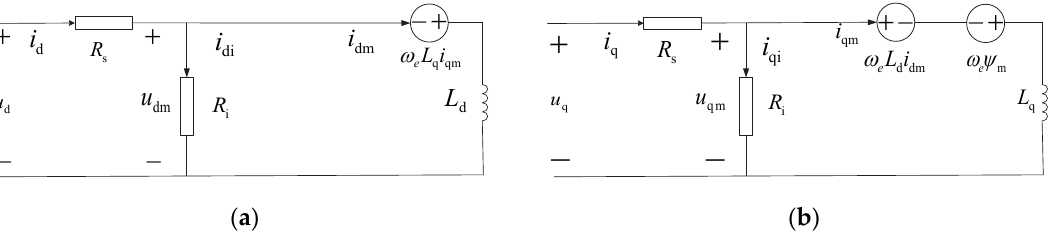
Figure 1. ( a ) D ‐ axis equivalent circuit; ( b ) Q ‐ axis equivalent circuit. Figure 1. ( a ) D-axis equivalent circuit; ( b ) Q-axis equivalent